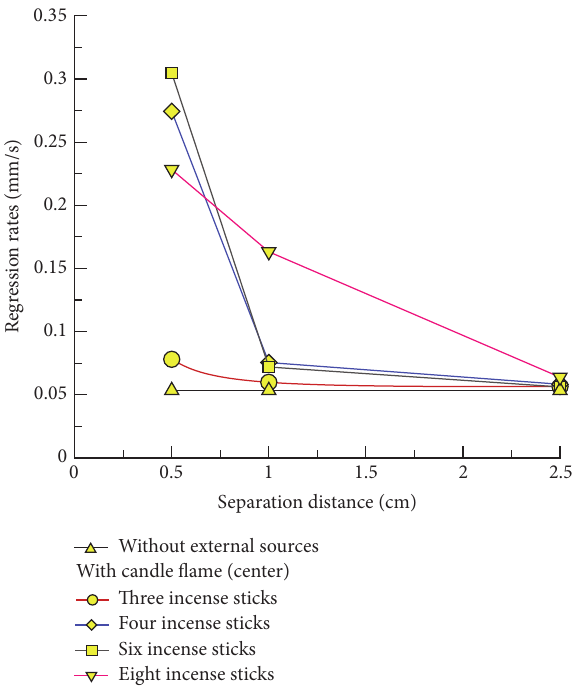
Figure 7: Nearfield effect of external heat source configurations and separation distance on